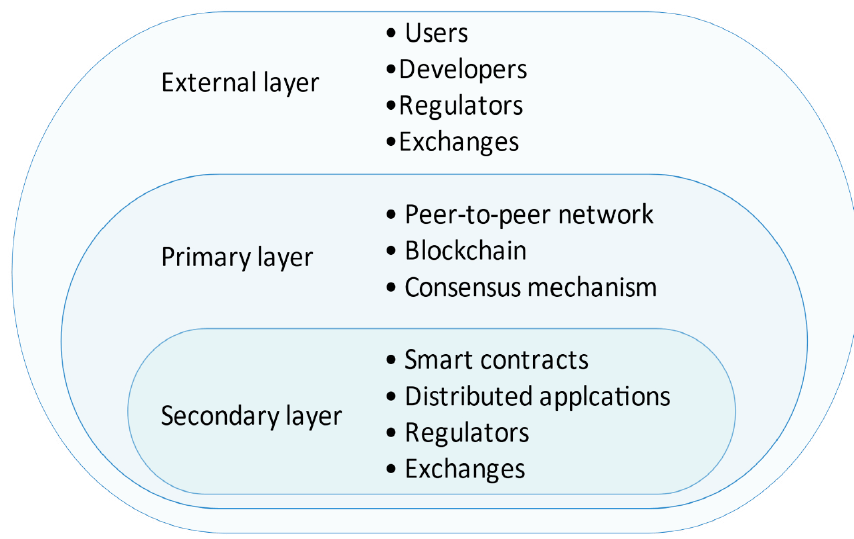
Figure 1: Layers in a blockchain